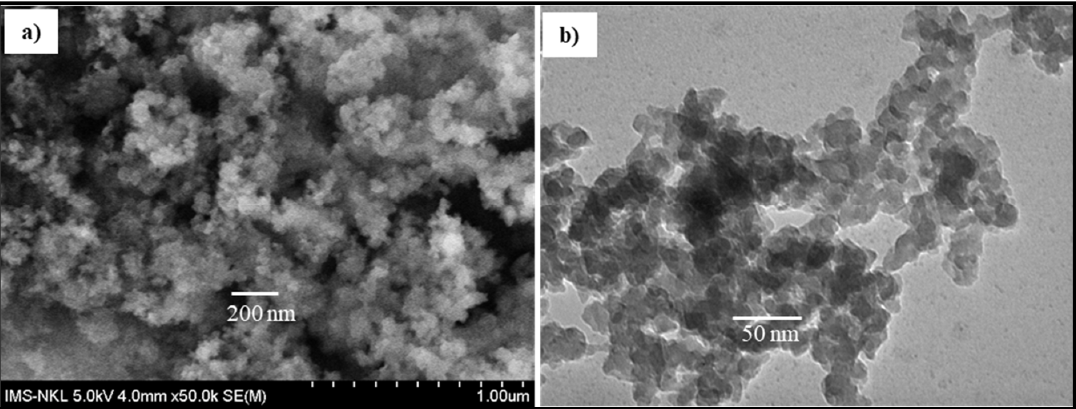
Figure 2. Field emission scanning electron microscopy (FESEM) ( a ) and transmission electron microscopy (TEM) ( b ) images of used SiO 2 nanoparticles.